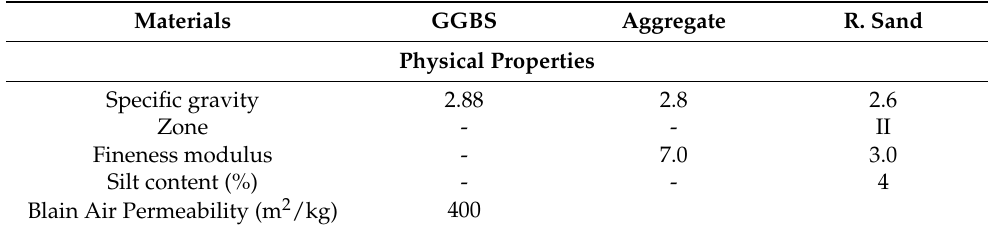
Table 2. Physical properties of ingredients of